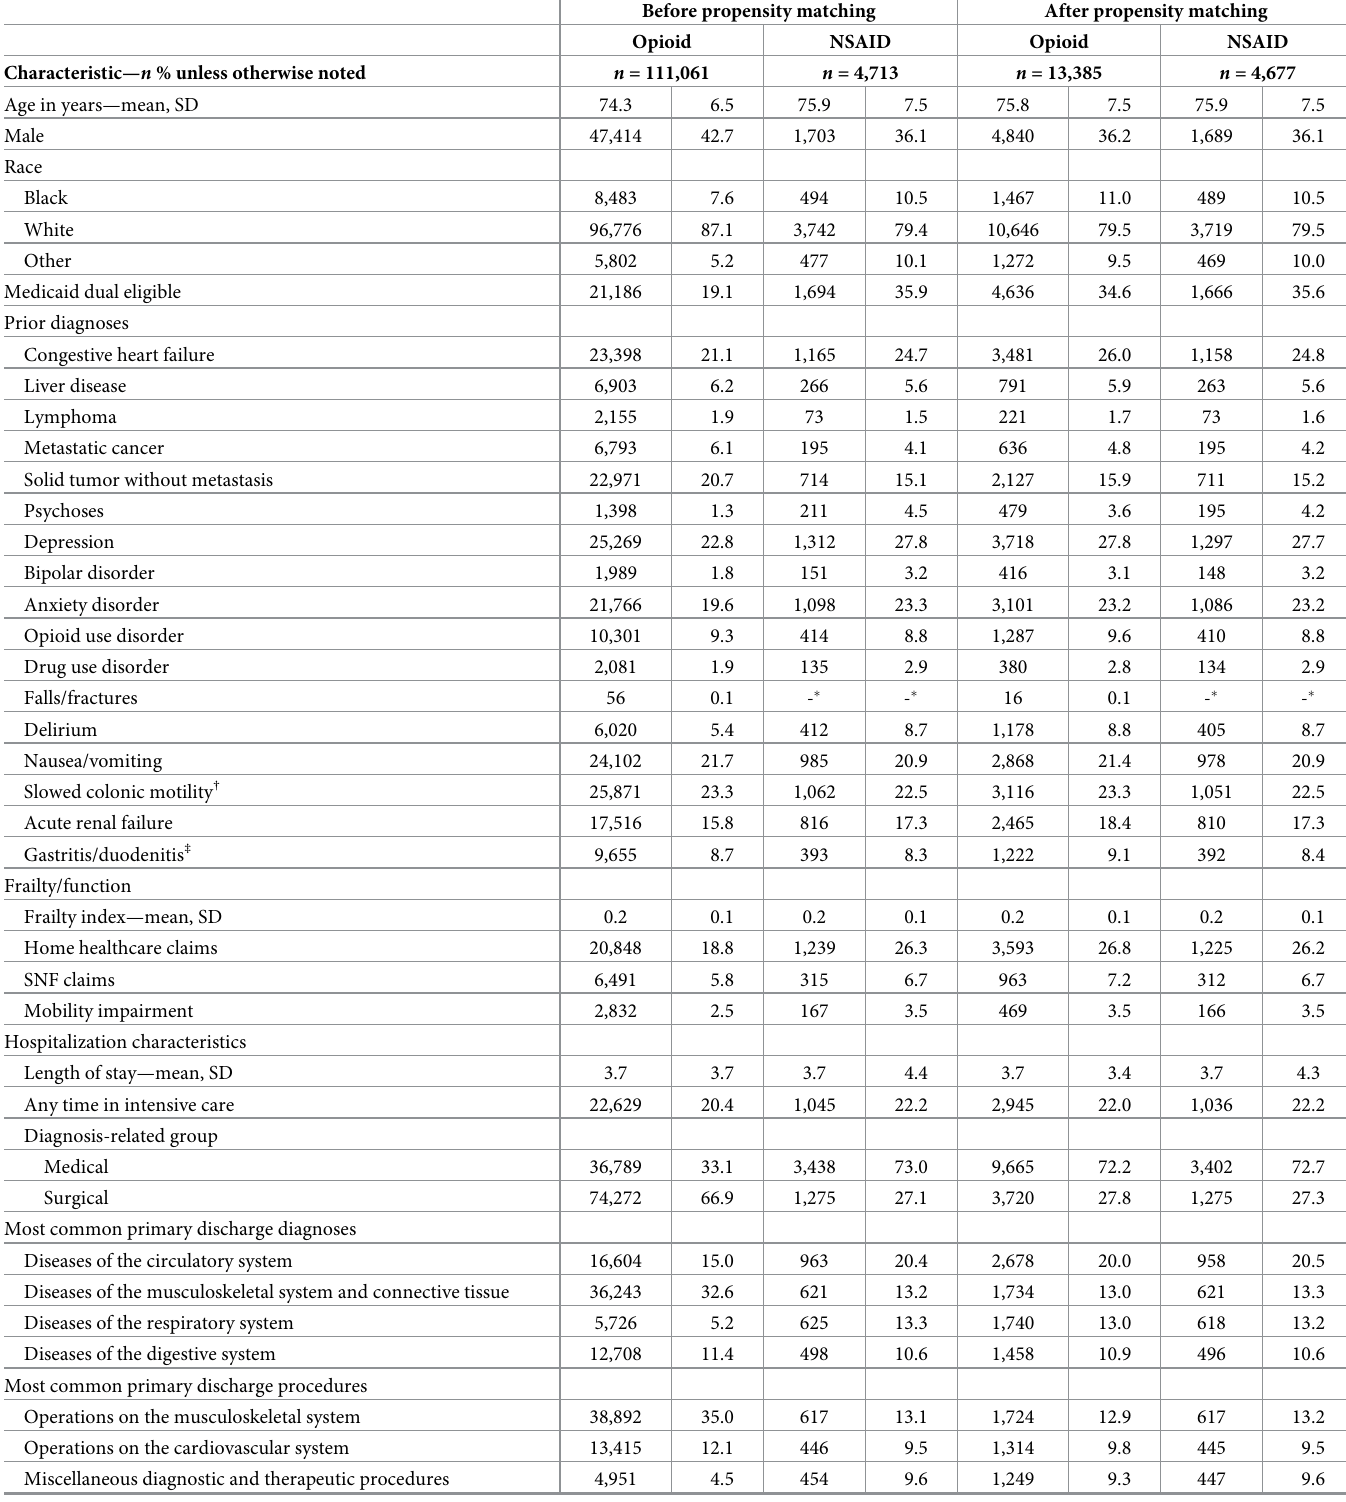
Table 1. Characteristics of study population, before and after propensity matching (see S1 Fig for SMDs; all were < 0.1 after the match). Before propensity matching After propensity matching Opioid NSAID Opioid